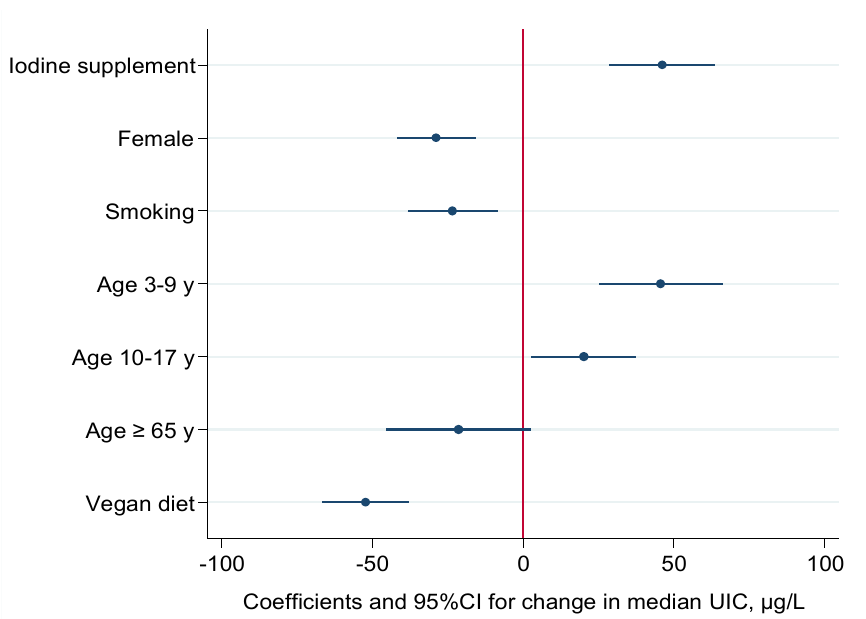
Figure 2. Plot showing the change in median urinary iodine concentration (UIC) μ g/L, coefficients and 95% confidence interval for supplement use, sex, smoking, age and vegan dietary practice. N = 276. Regressing creatinine ‐ adjusted UIC as the dependent variable (urinary iodine as μ g/g creatinine rather than μ g/L) resulted in comparable coefficients for the differences between iodine ‐ supplement vs. non ‐ supplement users, children vs. adults, and vegans vs. non ‐ vegans. However, the differences in UIC between non ‐ smokers vs. smokers, adults vs. adolescents, and adults vs. elderly disappeared when UIC were adjusted for creatinine (data not shown).